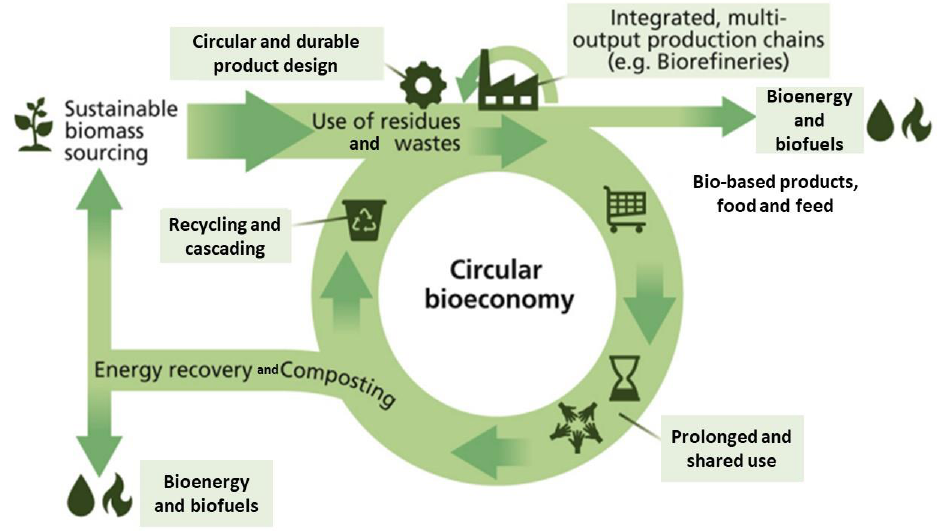
Figure 1. The circular bioeconomy and its elements [5] (with permission of Elsevier, Copyright year: 2022).